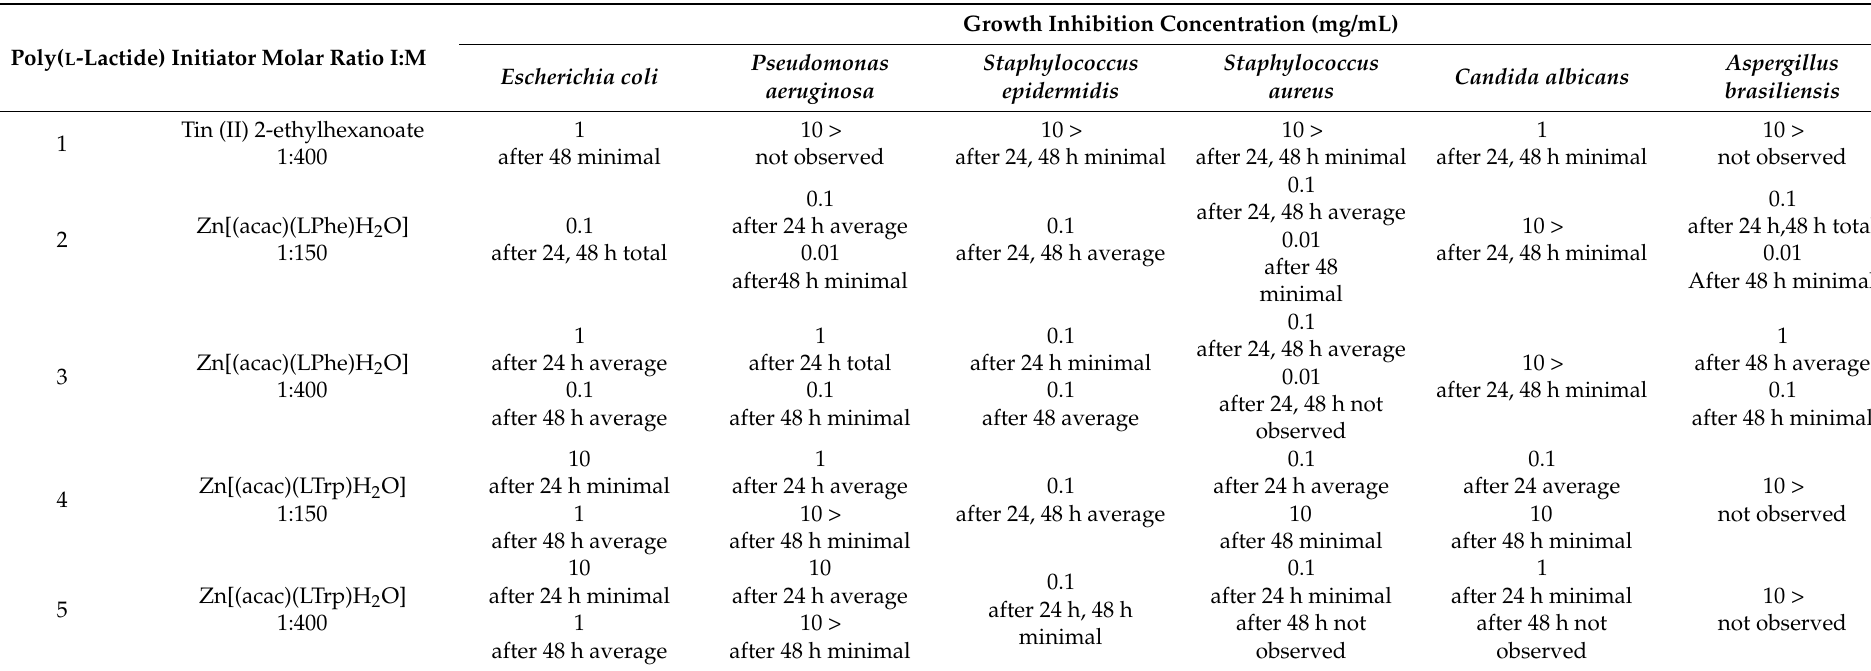
Table 2. Screening of the effect of the presence of selected samples of poly( L -lactide) on the inhibition of the growth of bacteria and fungi strains.